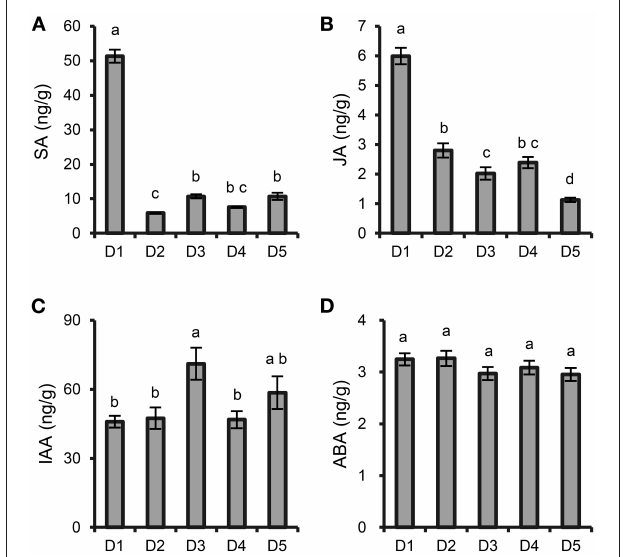
FIGURE 2 | Effects of plant density on phytohormone content in P. notoginseng roots. (A) SA. (B) JA. (C) IAA. (D) ABA. D1-D5 represent P. notoginseng grown at densities of 8 × 8, 10 × 10, 15 × 15, 20 × 20, and 30 × 30cm, respectively. All data are presented as the mean ± standard error (SE). Different letters indicate statistically significant differences among different treatments ( p < 0.05; n =